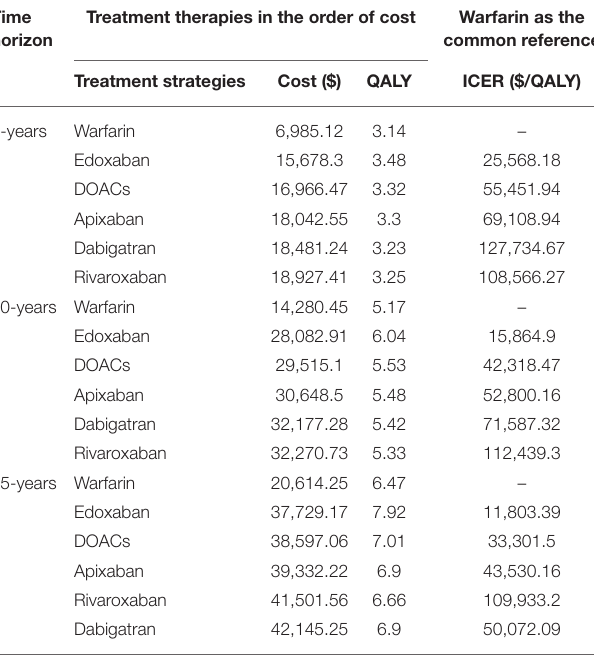
TABLE 3 | Projected clinical events, costs, health benefits, and incremental ICER for base-case analysis over a 10-years life horizon in OSs and RCTs.